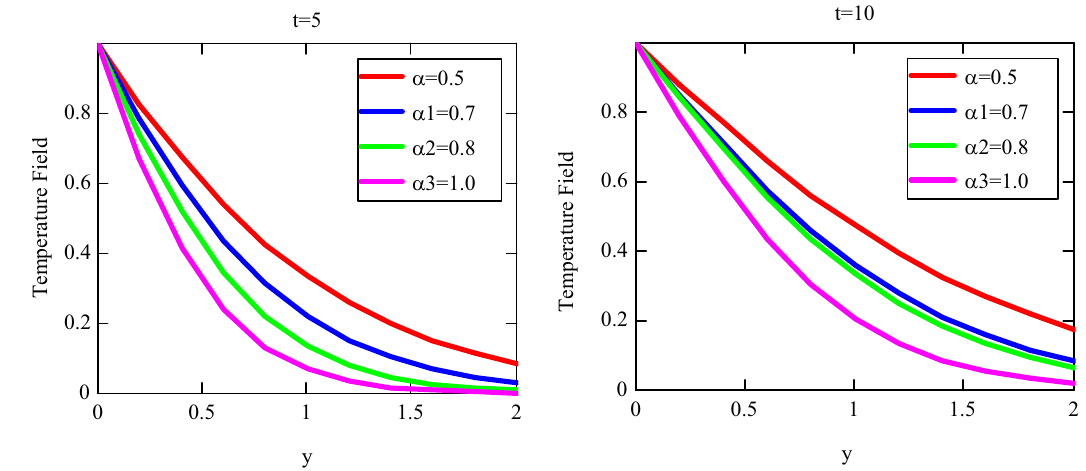
Figure 6: The fl uid temperature for the variants of the fractional